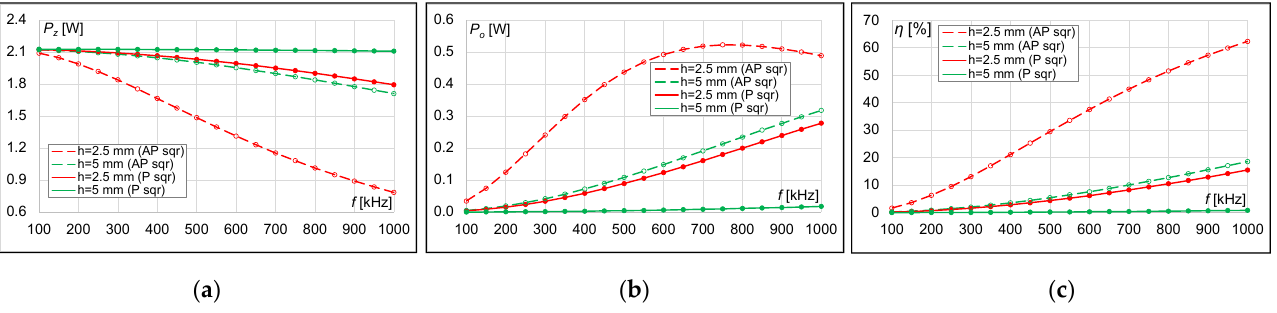
Figure 12. Results for square coils with r = 5 mm and the number of turns n = 15 at two distances ( h = 2.5 mm and h = 5 mm): ( a ) transmitter power, ( b ) receiver power, ( c ) power transfer efficiency.